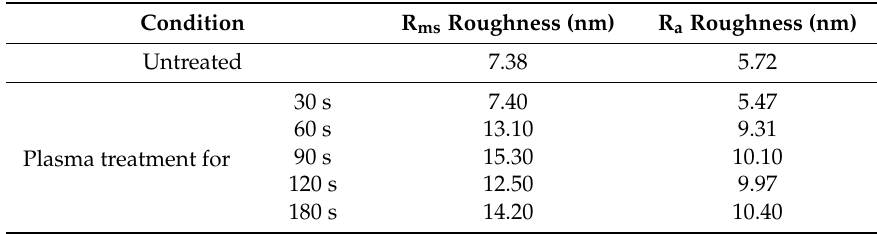
Table 1. Surface roughness of POM fiber before and after the DBD plasma treatment.